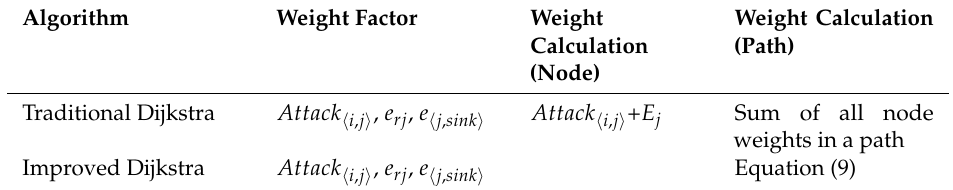
Table 1. Comparison of the improved Dijkstra algorithm and the traditional Dijkstra